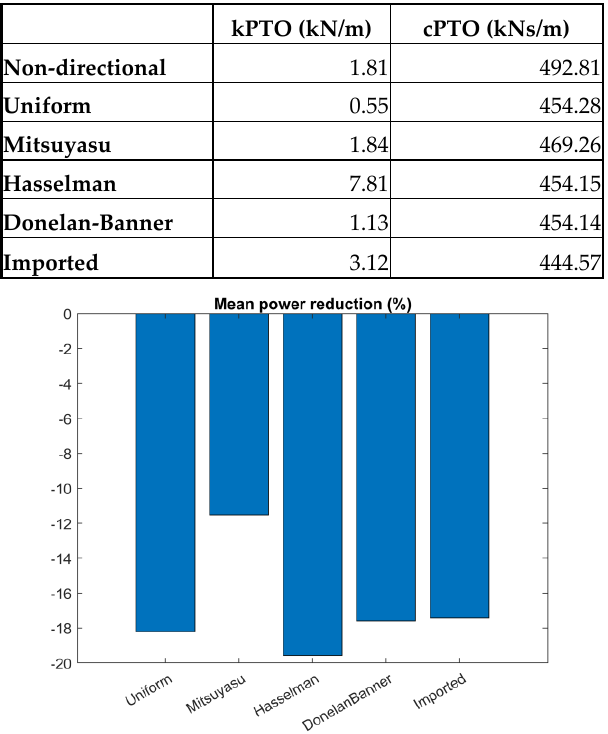
Fig. 7: Reduction of the mean power between the frequency- directional distribution cases and the non-directional